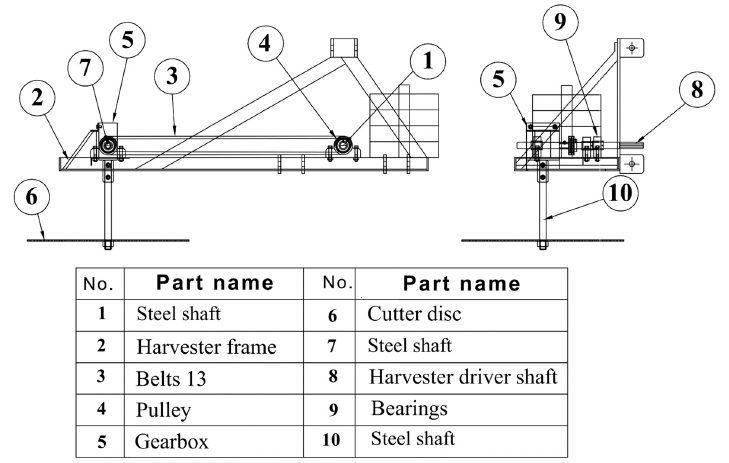
Figure 3. Power transmission